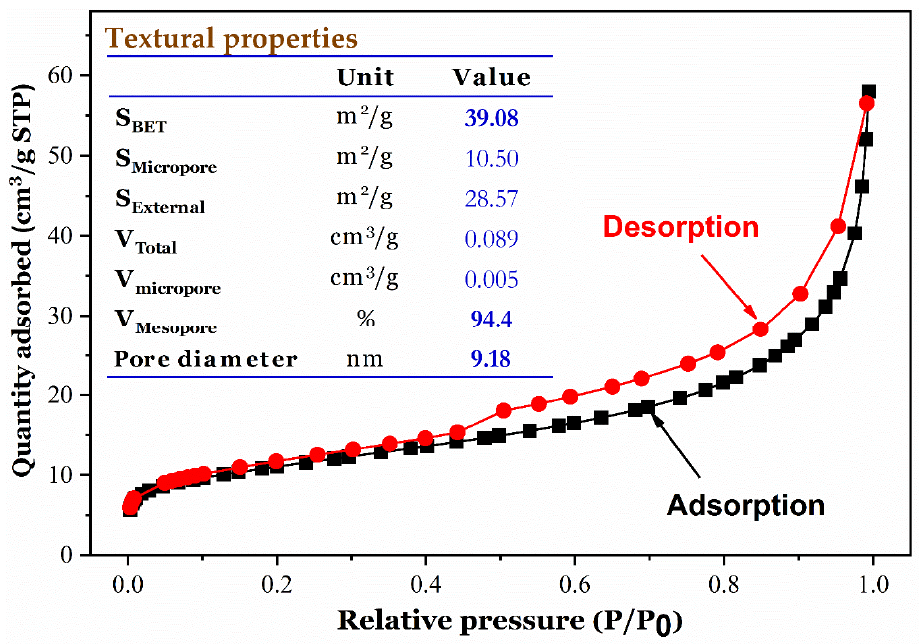
Figure 3. N 2 adsorption/desorption isotherm of DSD material at 77 K and its textural characteristics.